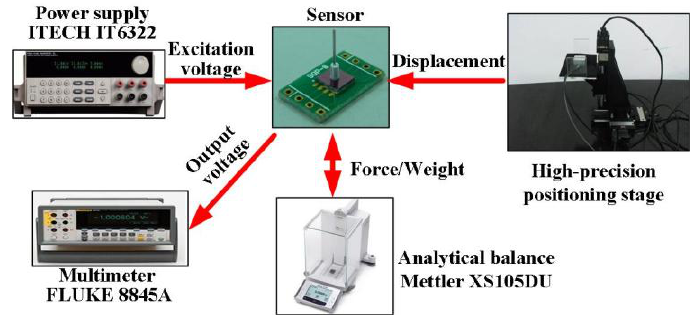
Figure 11. The setup for sensor